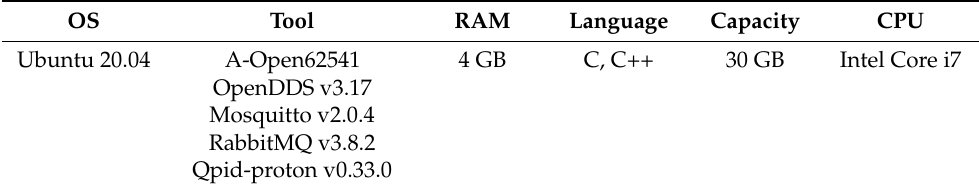
Table 8. System specifications for the performance analysis